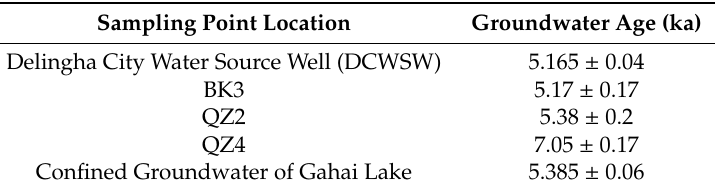
Figure 8. Stability diagram for silicate systems ( a ) Ca 2 + -H + -SiO 2 , ( b ) Mg 2 + -H + -SiO 2 , ( c ) Na + -H + -SiO 2 , ( d ) K + -H + -SiO 2. Table 6. Groundwater ages in the study